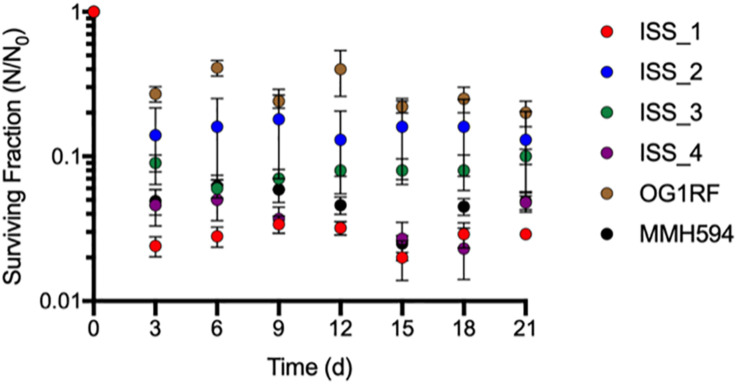
Desiccation survival of Enterococcus faecalis strains from the ISS and the control strains, OG1RF and MMH594. The data are presented as the average (± SD) of triplicate measurements. Some error bars have been obscured by the data points.